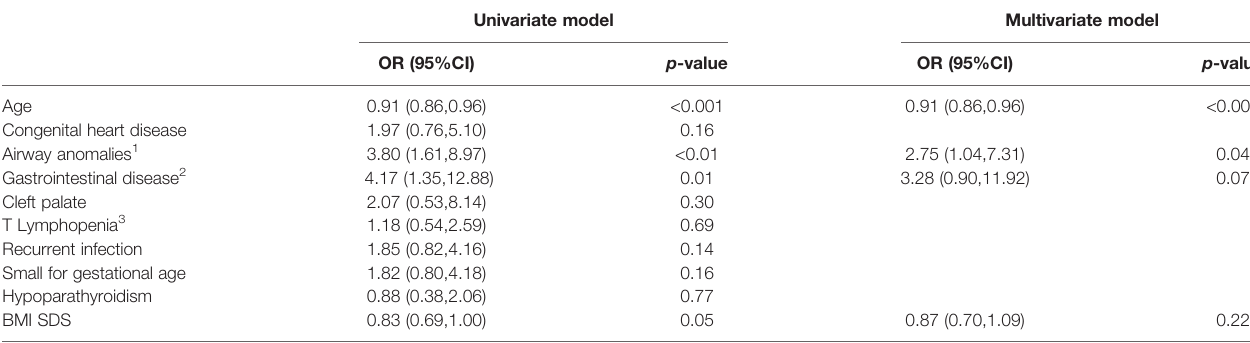
TABLE 2 | Univariate and multivariate logistic regression analysis of risk factors for short